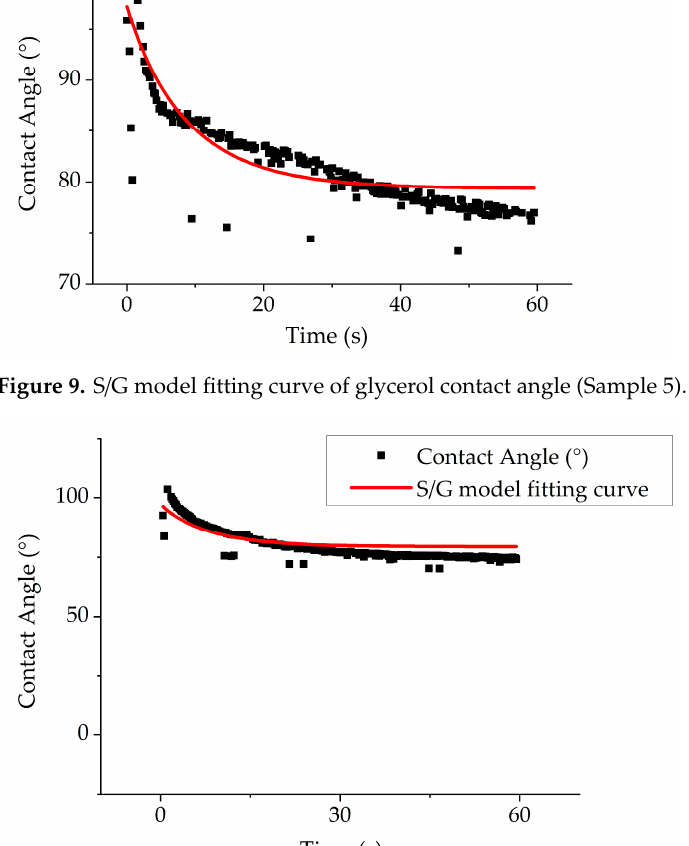
Coatings 2020 , 8 , x FOR PEER REVIEW 11 of 13 Figure 10. S / G model fitting curve of glycerol contact angle (Sample 6). Figure 10. S/G model fitting curve of glycerol contact angle (Sample 6). Figure 10. S/G model fitting curve of glycerol contact angle (Sample 6).